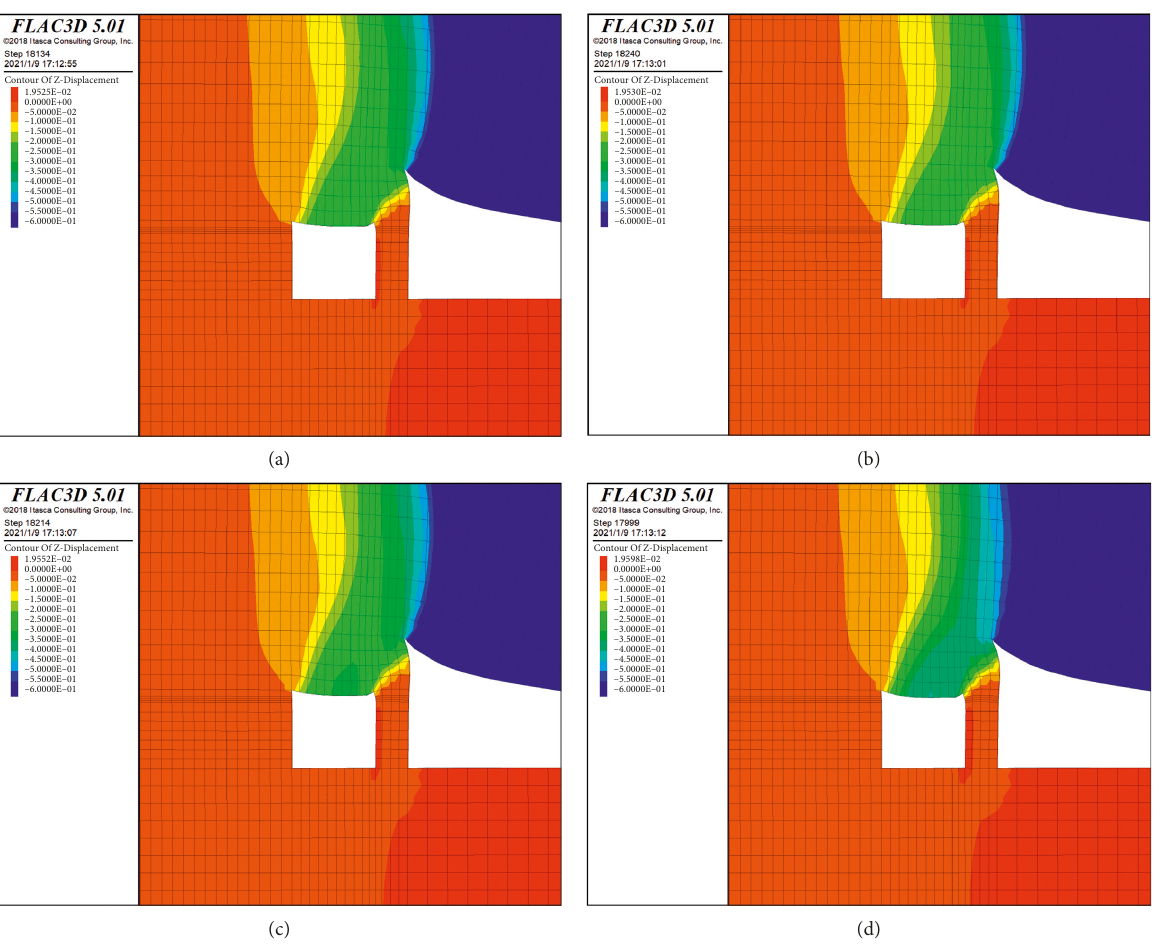
Figure 6: Displacement cloud diagram of surrounding rock of roadway at different heights when the “combined” wall is connected to the top floor (unit: mm). (a) 300mm. (b) 400 mm. (c) 500 mm. (d) 600mm.